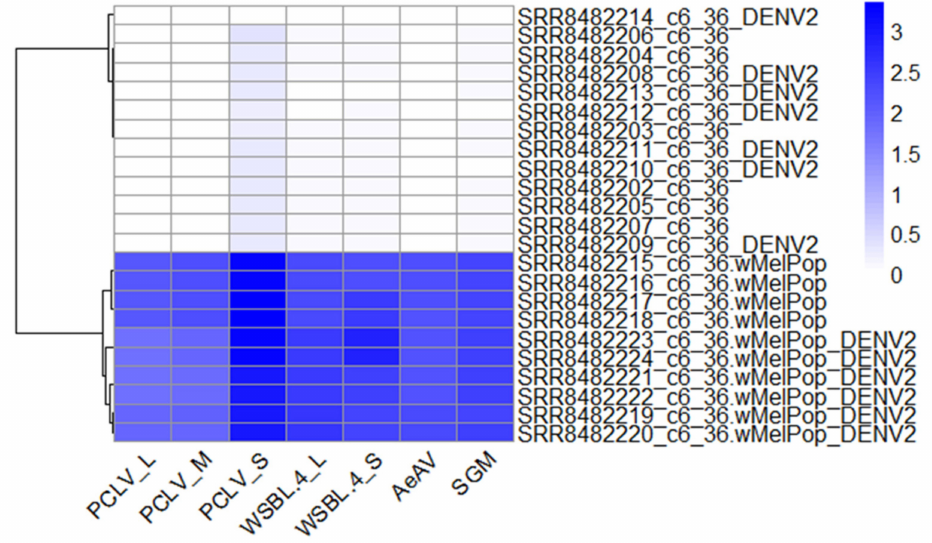
Figure 11. Evidence of ISV super-infection in Wolbachia -infected C6/36 cells. Heat map of data from Teramoto et al. 2019 [65]. Abundance is represented as log 10 (RPKM) mapped reads per million per kilobase. Hierarchical clustering was performed using Pearson complete distance measurement method. Heat map produced using pheatmap R package. Labels are: PCLV: Phasi Charoen-like virus, WSBL4: Wenzhou-Sobemo-like virus 4, AeAV: Aedes aegypti anphevirus, SGM: San Gabriel